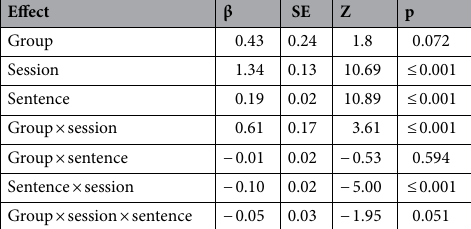
Table 1. Fixed effects and interactions from the full learning